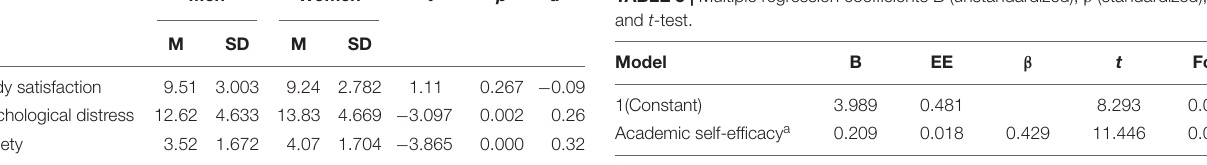
TABLE 2 | Study satisfaction, psychological distress, anxiety, and academic self-efficacy between men and women. Men